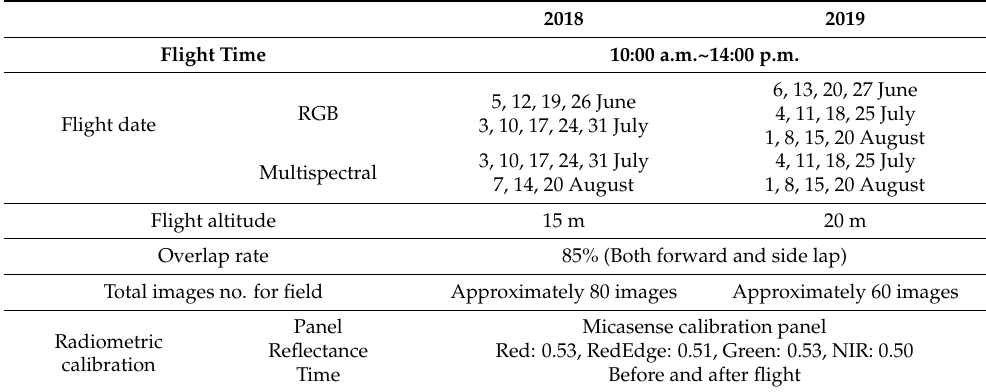
Table 1. Characteristics and configuration of UAV utilization for data